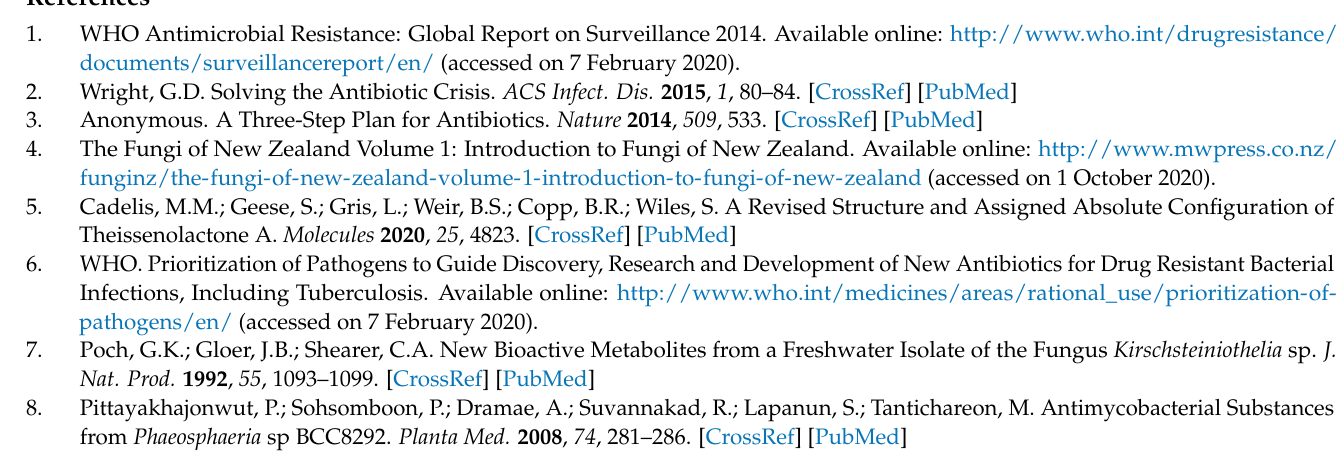
Supplementary Materials: The following are available online. The 1 H (Figure S1), 13 C (Figure S2), COSY (Figure S3), HSQC (Figure S4), HMBC (Figure S5) and ROESY (Figure S6) NMR spectra, HRESIMS (Figure S7) and HPLC trace (Figure S8) for neofusnaphthoquinone B ( 1 ) and initial antibacterial screening results from zone of inhibition assays (Figure